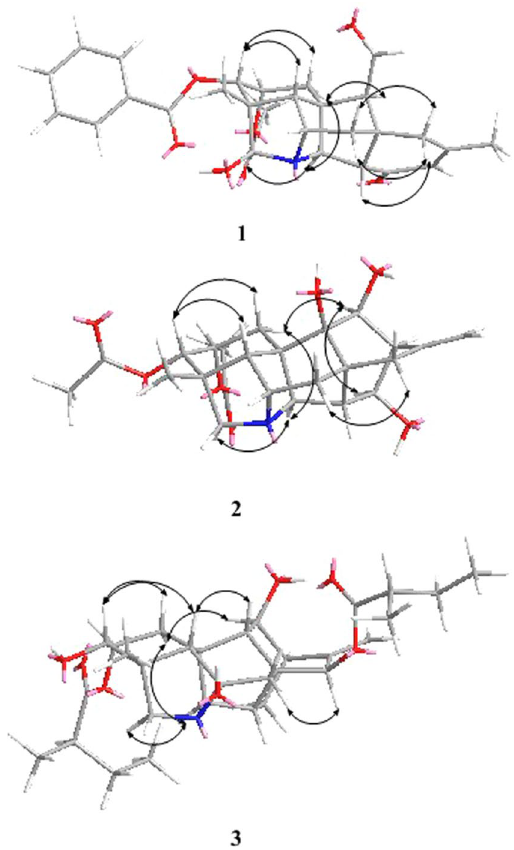
Figure 3. Key NOESY correlations of compounds 1–3 .